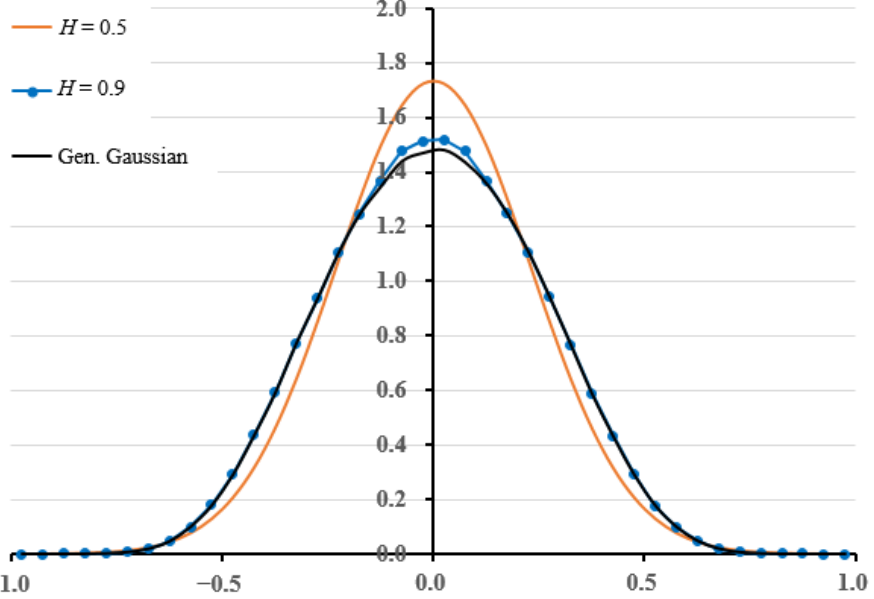
Figure 2. Fitting of the generalized Gaussian (Gen Gaussian) probability distribution with the em ‐ pirical one of the estimations of zero ‐ lag cross–correlations of series with H = 0.9 (shown in Figure 2).